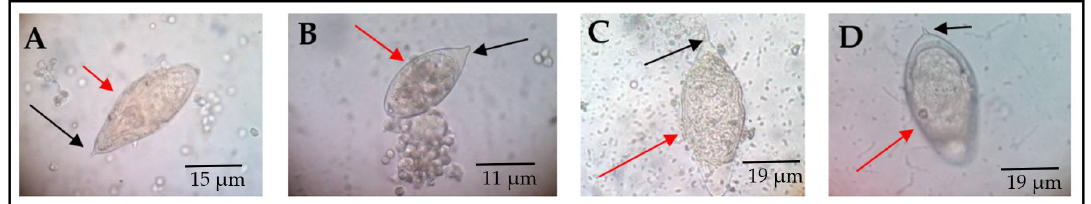
Figure 1. Morphological forms of S. haematobium ova. The red arrows point to the eggs, while black arrows indicate the spine. All eggs represented by ( A – D ) have the usual characteristic oval shape and terminal spine. However, ( B ) has a blunt spine, while ( D ) appears to be oval to round-shaped, with a slightly curved spine. These pictures were chosen from different participants as representative observations (source of images: authors’ laboratory work).